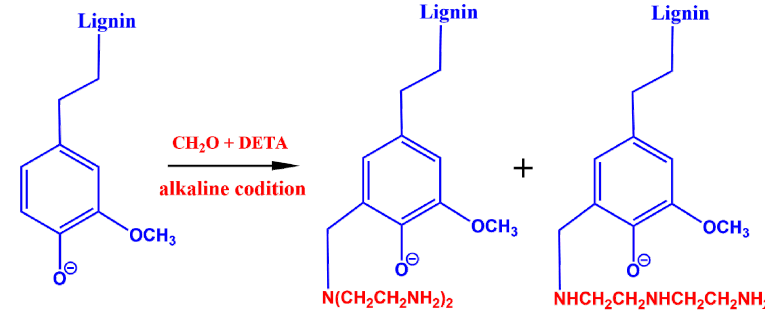
Figure 1. Synthesis of lignin amine.